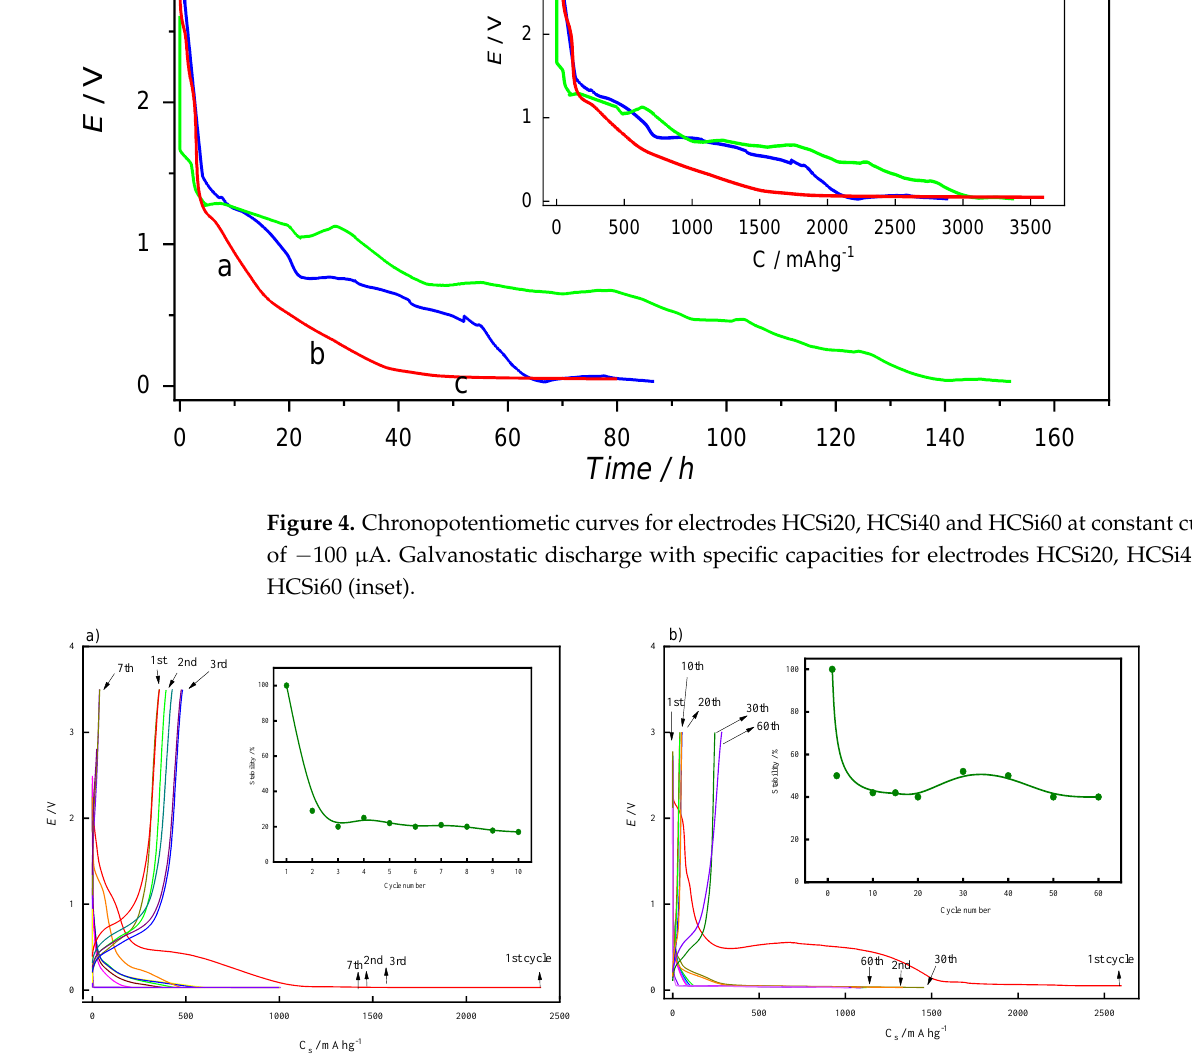
Figure 6. In situ GEIS impedance spectra for HCSi20 electrode in ( a ) Nyquist plot, ( b ) Bode plot. From the dependencies shown, it is evident that only the impedance spectrum meas- ured after one hour shows a low-frequency (LF) semicircuit connected with an additional series of parallel R ║ C combination. This impedance spectrum was measured at a potential of ≈ +2.5 V, as shown by the chronopotentiometry curve in Figure 4, when the primary SEI is formed. As a result, the formation of SEI may be associated with the formation of an LF semicircuit; however, the impedance spectra measured at other refute this assumption. This LF semicircuit disappears in the other impedance spectra, so it is impossible to asso- ciate the formation of the primary SEI with the existence of this LF semicircuit. Since the conditions for the intercalation process are not met at this potential, the layer acts as a resistor. A semicircle associated with the charge transfer resistance (R ct ) on and within the -1